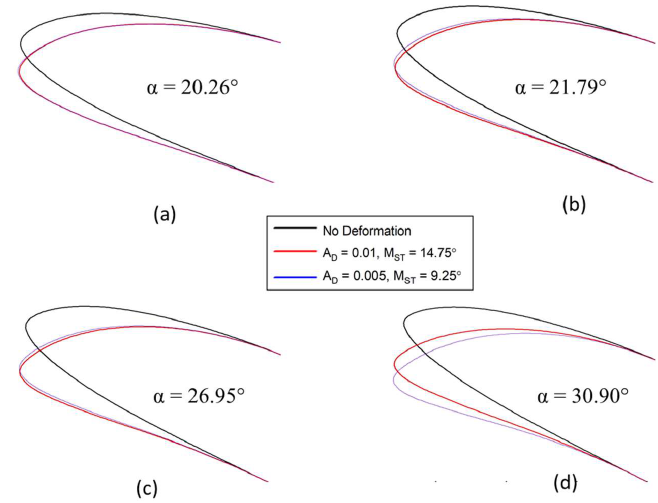
Figure 7. The reference airfoil in comparison with the DMLE airfoils; ( a ) both the dynamically morphing airfoils are overlapping each other at pitch angle of 20.26°, ( b ) the airfoil with 𝐴 (cid:3005) = 0.01 deflects more even the morphing starts after 𝐴 (cid:3005) = 0.005 at pitch angle of 21.79°, ( c ) the deflection of 𝐴 (cid:3005) = 0.005 airfoil is increasing and ( d ) the deflection of 𝐴 (cid:3005) = 0.005 airfoil is large as compared to 𝐴 (cid:3005) = 0.01 because it continues to morph till higher pitch angles. These figures show that the droop nose amplitude and morphing starting time have significant effect on the airfoil leading edge shape.